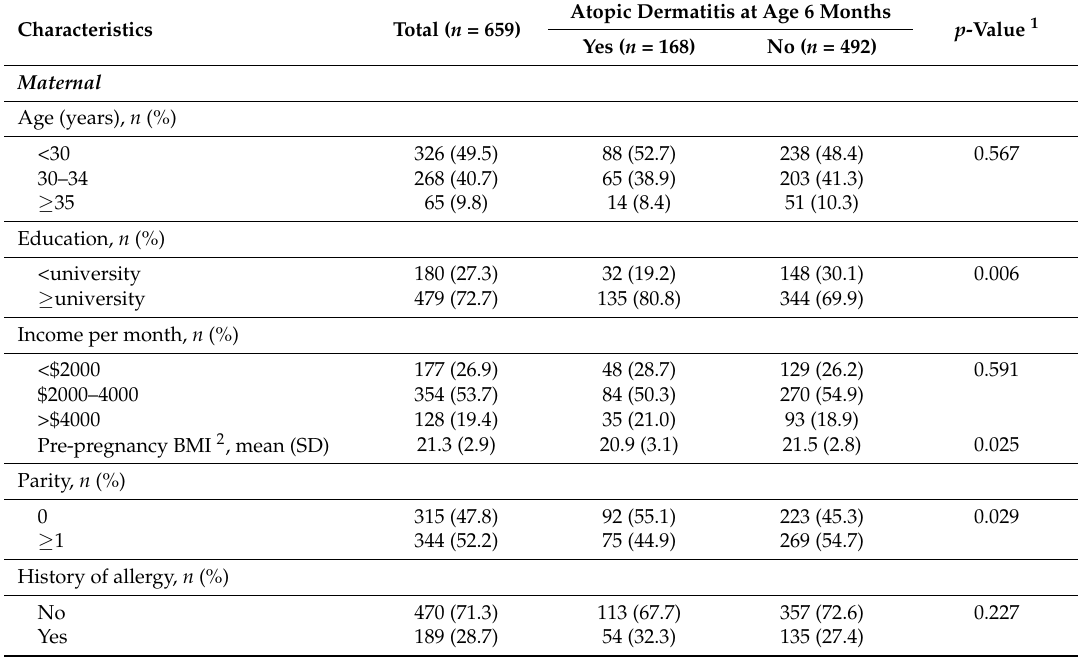
Table 1. Characteristics of study